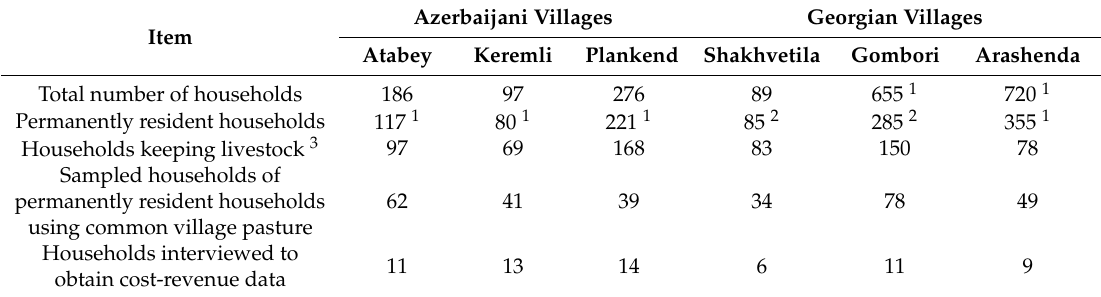
Figure 1. Map of the study area indicating the study villages in bold. Source: [55]. Table 1. Overview of sampled households in the case study